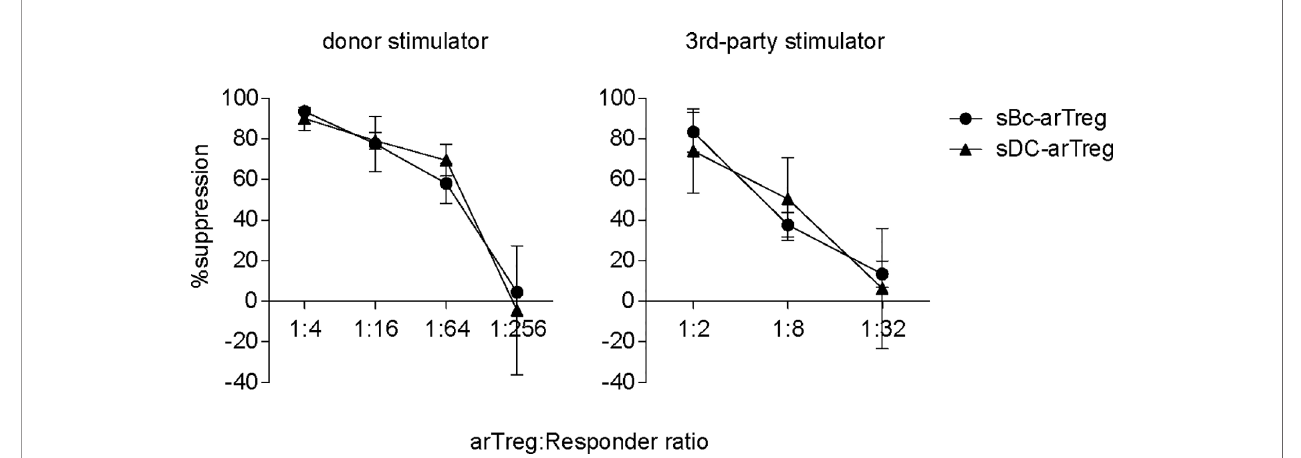
FIGURE 7 | Both sBc- and sDC-arTregs suppress T cell proliferation. Suppression of autologous PBMC proliferation by sBc- and sDC-arTregs that were stimulated from APC donor (left) or from third-party donor (right). Data contain n=2 (donor) and n=3 (third-party) different responder-stimulator combinations. Statistics were performed using unpaired t-test between sBc-arTregs and sDC-arTregs at the same Treg dilution.